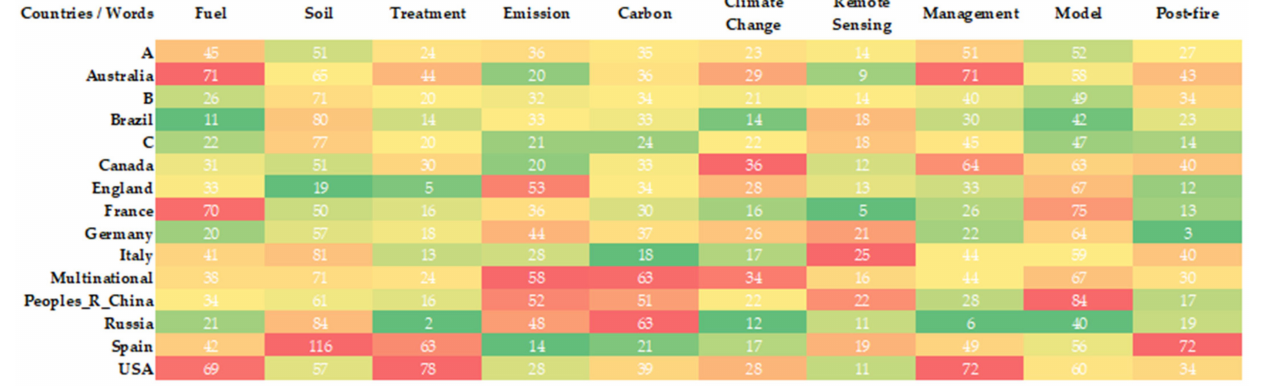
Figure 6. Heatmap of word mean importance weights ( × 10 − 2 ) by countries.